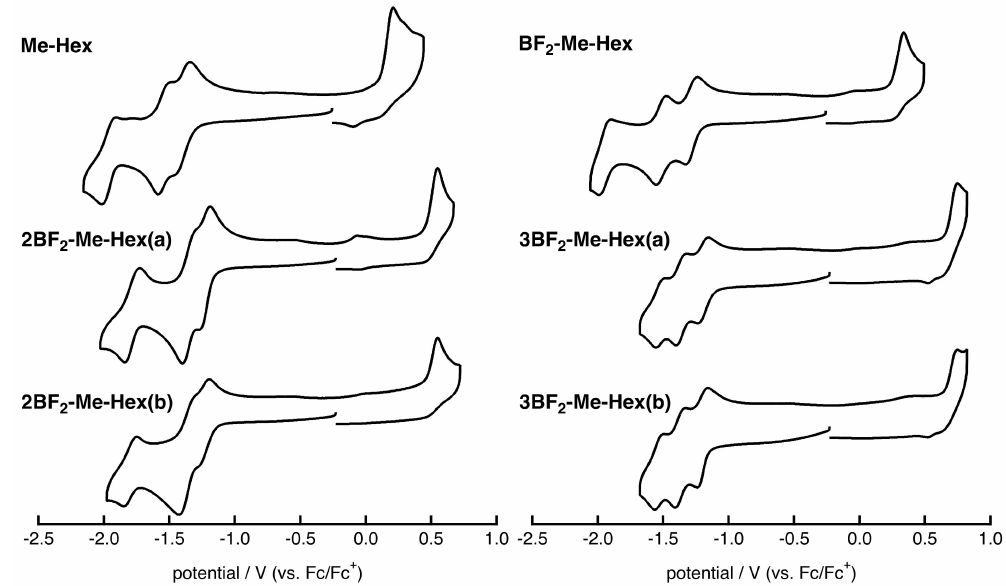
Figure 9. Cyclic voltammetry (CV) of Me-Hex and boron complexes in CH 2 Cl 2 with 0.1 M TBAPF 6 . Scan rate is 0.1 V s − 1